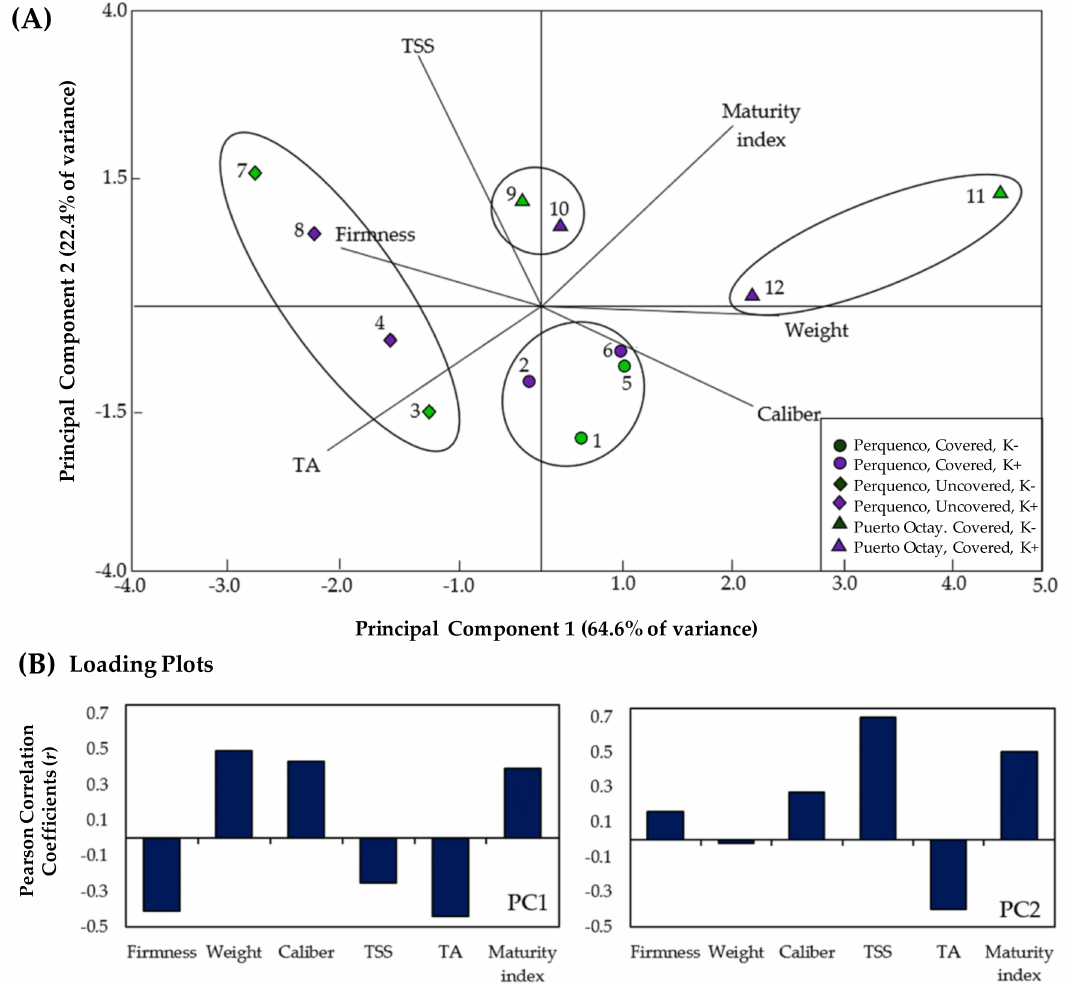
Figure 2. Results of principal component analysis (PCA): ( A ) dispersion plot of PC1 versus PC2 and ( B ) loading plots of PC1 and PC2, representing the main quality parameters of sweet cherry fruits based on different localities (Perquenco and Puerto Octay), seasons, use of plastic covers, and potassium (K) foliar fertilization regimes. Trees of sweet cherry (cultivar Regina) were subjected to two foliar potassium (K) treatments: a conventional K regime (4 sprays during the season: K − treatment) or an intensive K regime (7 sprays during the season; K+ treatment). In each location, the assays were conducted in two consecutive seasons. In the Perquenco orchard, covered and un-covered trees were compared. The points within the scatter plot are: Perquenco orchard, 2018/2019 season, covered, treated with K − regime (1), Perquenco orchard, 2018/2019 season, covered, treated with K+ regime (2), Perquenco orchard, 2018/2019 season, un-covered, treated with K − regime (3), Perquenco orchard, 2018/2019 season, un-covered, treated with K+ regime (4), Perquenco orchard, 2019/2020 season, covered, treated with K − regime (5), Perquenco orchard, 2019/2020, covered, treated with K+ regime (6), Perquenco orchard, 2019/2020 season, un-covered, treated with K − regime (7), Perquenco orchard, 2019/2020 season, un-covered, treated with K+ regime (8), Puerto Octay orchard, 2019/2020 season covered, treated with K − regime (9), Puerto Octay orchard, 2019/2020 season, covered, treated with K+ regime (10), Puerto Octay orchard, 2020/2021 season, covered, treated with K − regime (11), and Puerto Octay orchard, 2020/2021 season, covered, treated with K+ regime (12). Abbreviations: TSS (total soluble solids), AT (titratable